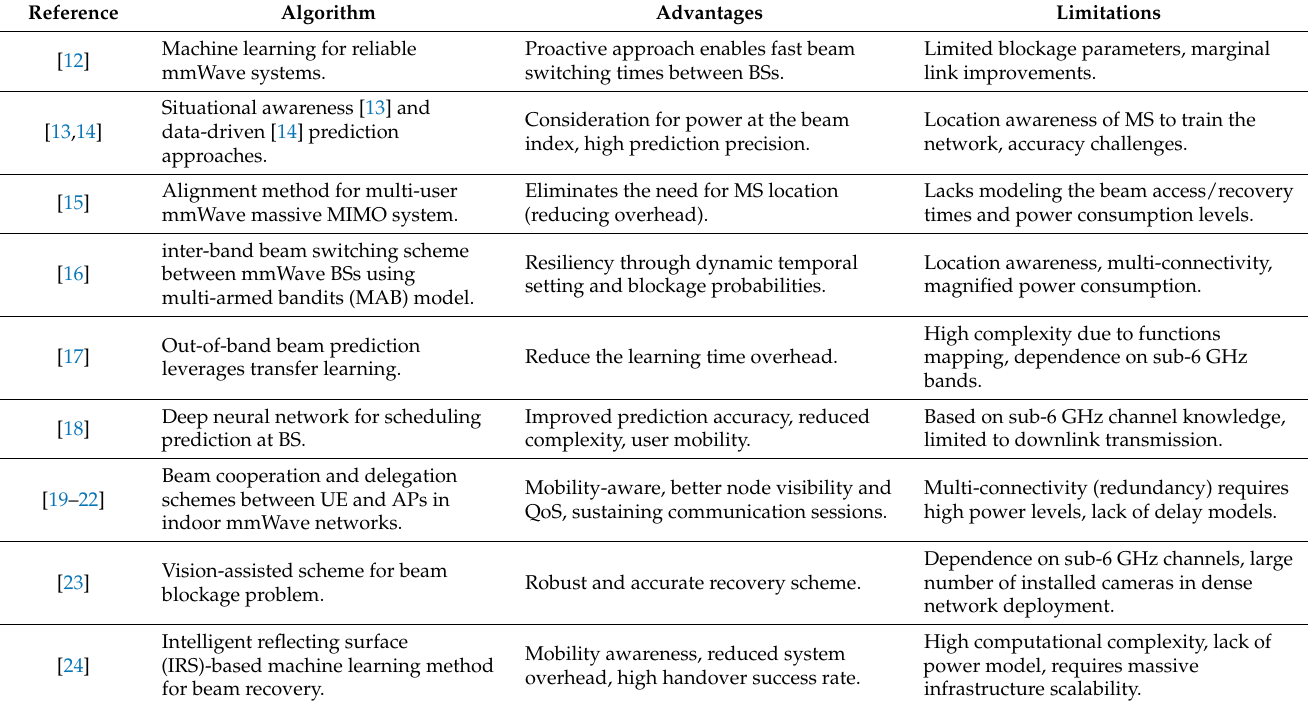
Table 2. Existing research on beam recovery techniques based on deep learning networks.